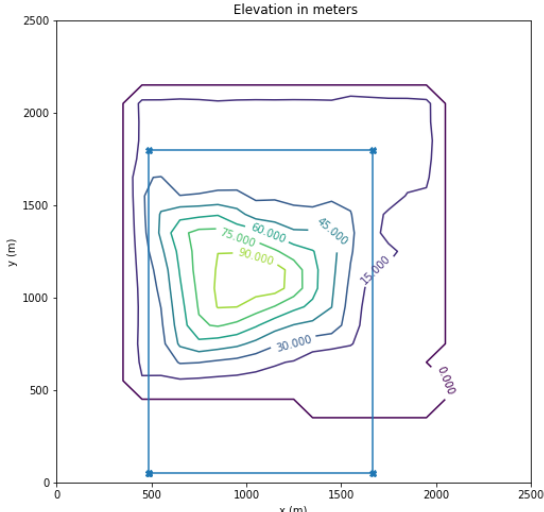
Figure 1. Model domain and terrain elevation above local background for Facility A. Blue line is approximate border of the landfill.